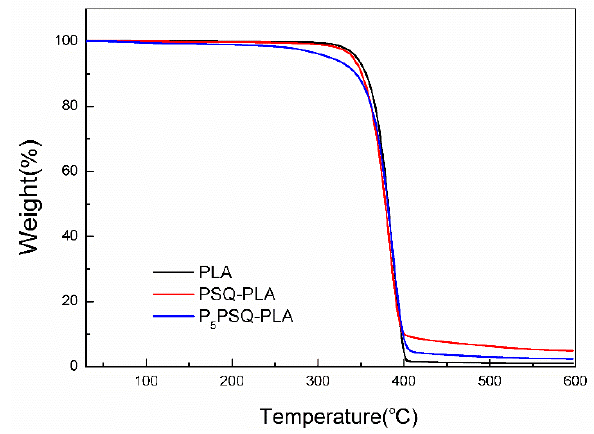
Figure 7. TG curves of neat PLA and its flame retardant composites.